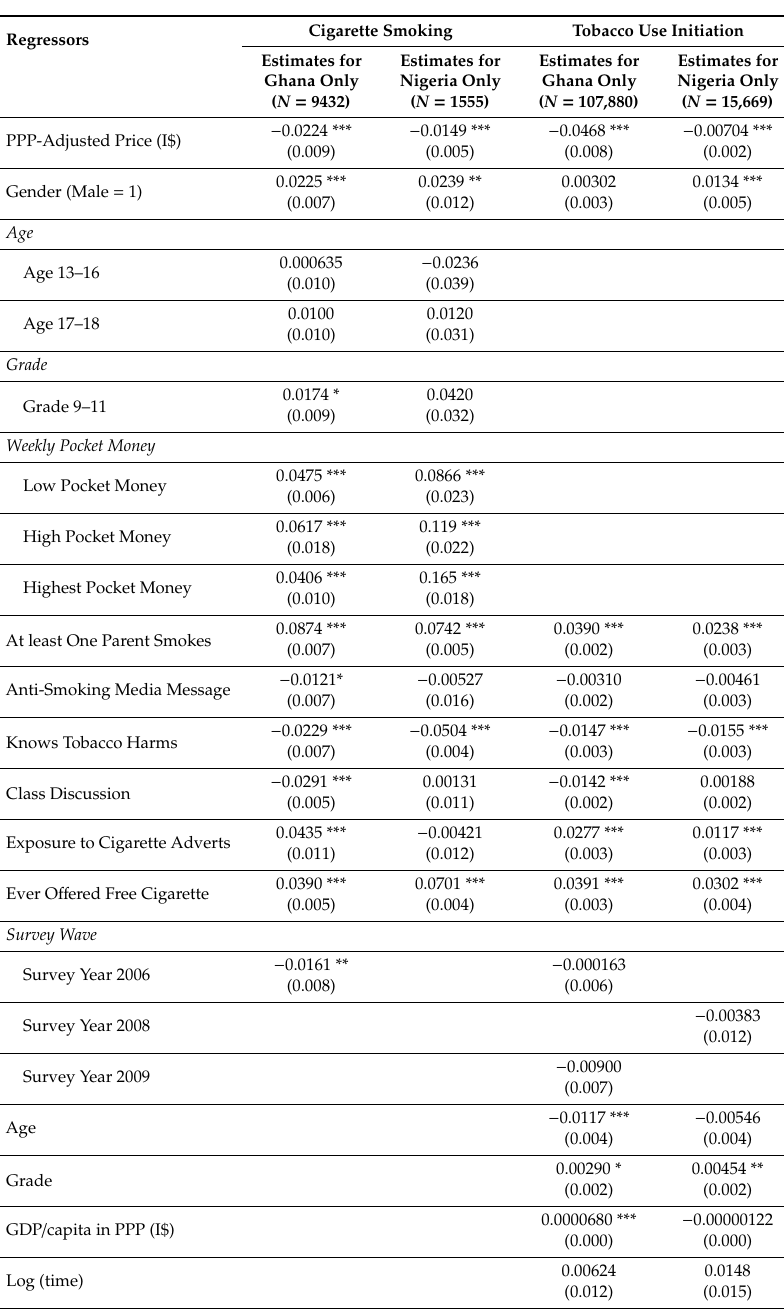
Table 6. E ff ect of PPP-adjusted cigarette price (in I$) on cigarette smoking and tobacco use initiation using a country-specific